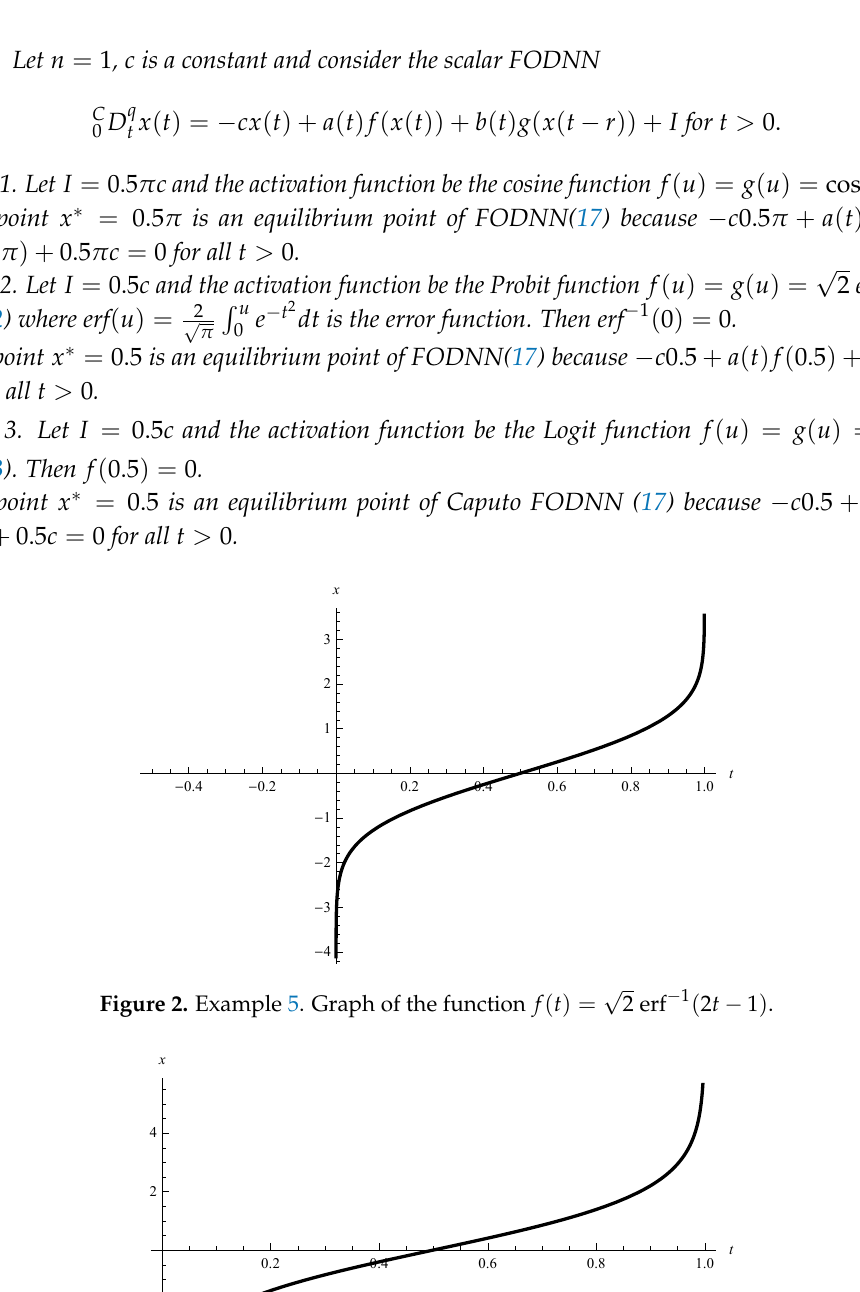
Figure 3. Example 5. Graph of the function f ( u ) = log